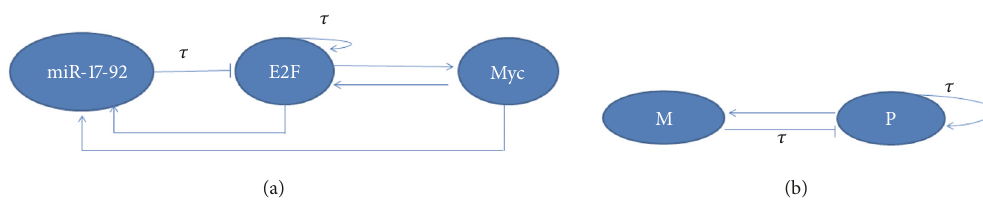
Figure 1: Anillustration of the networkinvolving miR-17-92, E2F and Myc (a)and its abstractmodel(b), whereP and M representthe protein module (E2Fs and Myc) and miR-17-92 cluster,